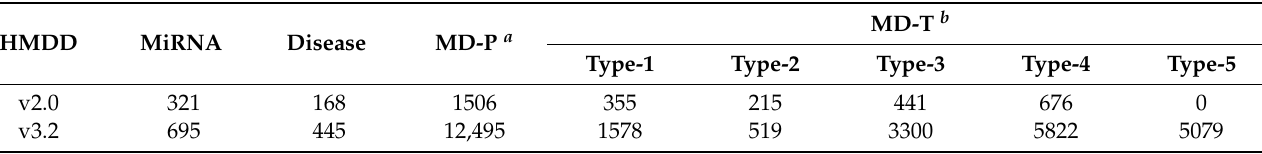
Table A1. Details of the two data sets in this work: a represents miRNA-disease pair association, and b represents miRNA-disease-type